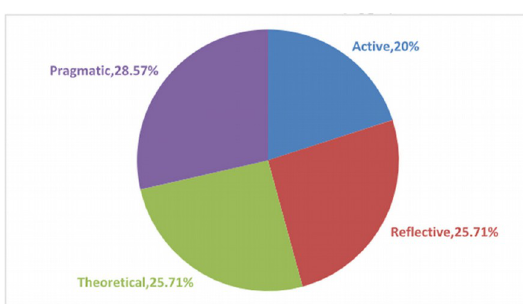
Figure 17. Distribution of learning